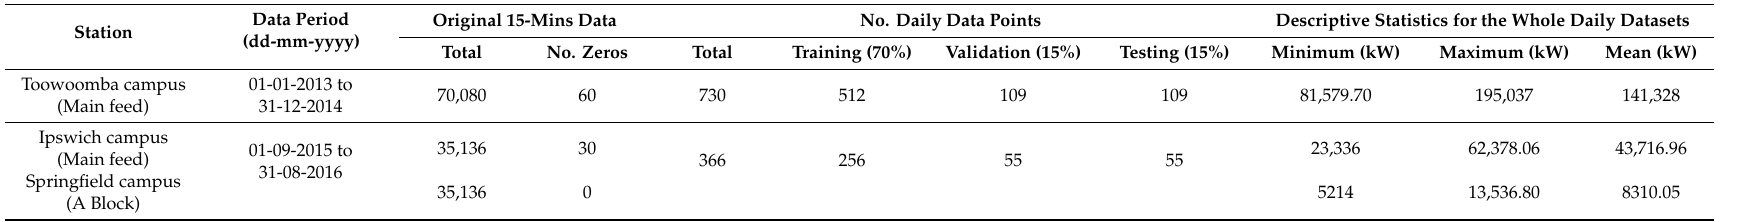
Table 1. Data splitting and descriptive statistics for the G data from the University of Southern Queensland campuses’ three